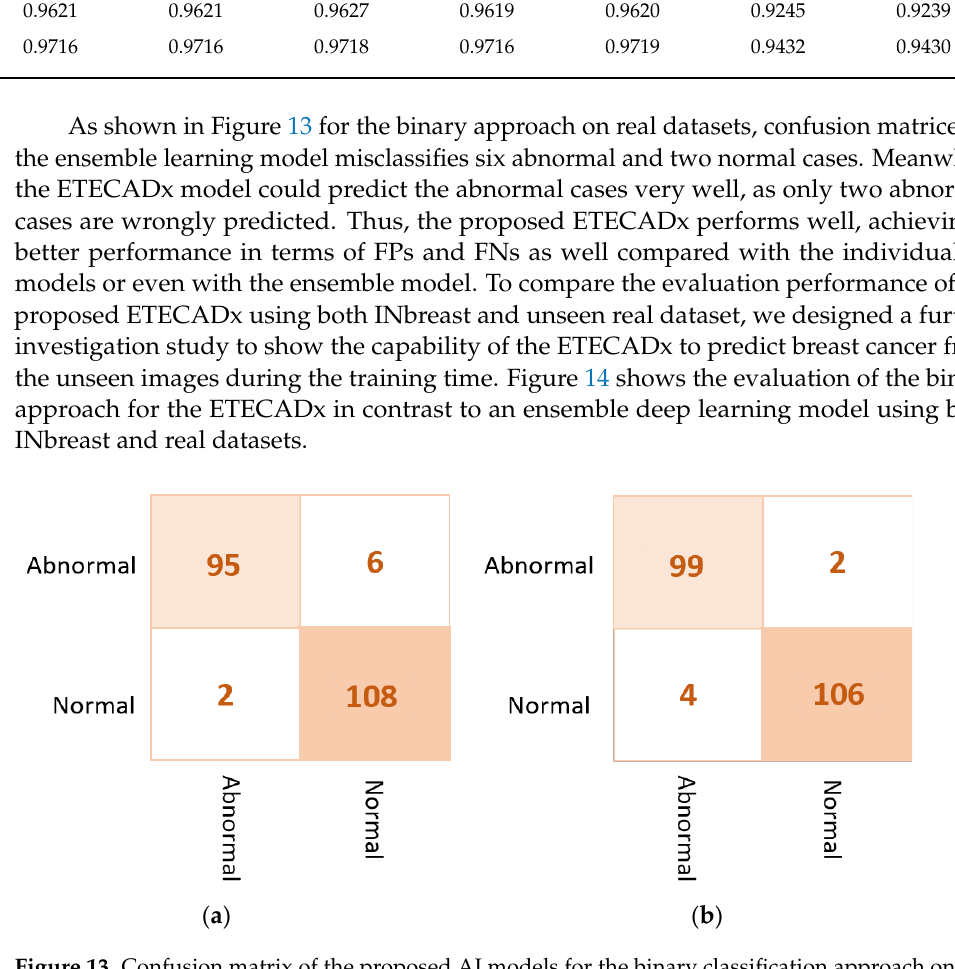
Figure 14. Comparison results of the binary approach for the ETECADx model against the ensemble learning model in both INbreast and real datasets. 5.3.2. Approach B: Multi-Class Classification Approach For the multi-class approach, Table 11 presents the validation results of the proposed ETECADx framework against the ensemble learning model and other AI individual mod- els using the real dataset (i.e., Dataset2-B). We can summarize that the proposed ETECADx model could successfully outperform other individual and their ensemble models. The best validation classification results are achieved via the proposed ETECADx model by recording 89.41% Accuracy, 89.41% Sensitivity, 91.27% Specificity, 87.77% F1- score, and 83.83% AUC. The ensemble learning model got twenty-one cases wrong pre- dicted for benign cases, and six cases in malignant cases. Meanwhile, the ETECADx model is distinguished in prediction better than the ensemble learning model with wrong pre- dictions of eighteen, one, and six cases in benign, malignant, and normal cases, respec- tively, as shown in Figure 15. Similarly, we perform one more validation study to validate the capability of the proposed ETECADx system predicting new mammogram instances. The proposed CAD system is trained only using INbreast images, while the real breast